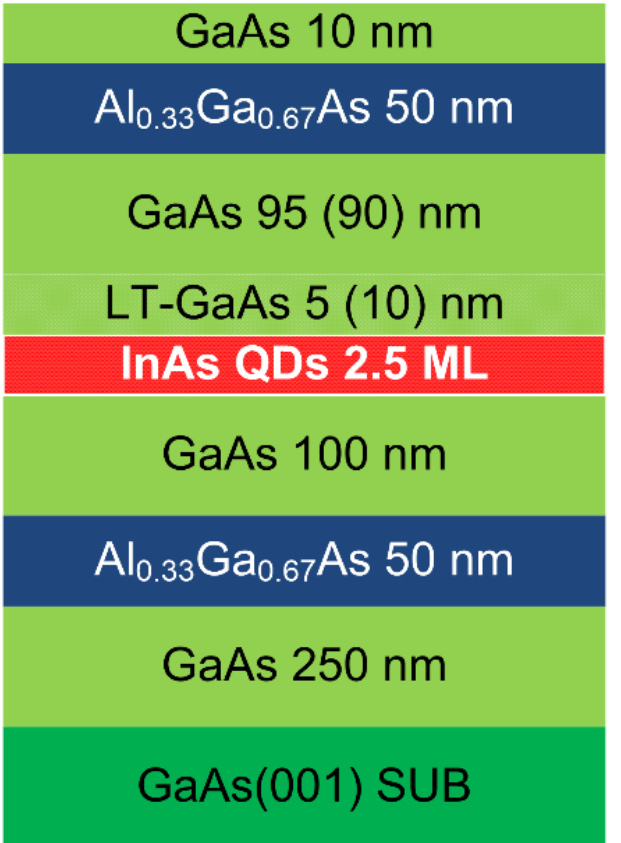
Figure 1. Schematic representation of a typical PL structure in which the LT-GaAs capping layer differs in the thickness and the arsenic pressure provided during the growth.